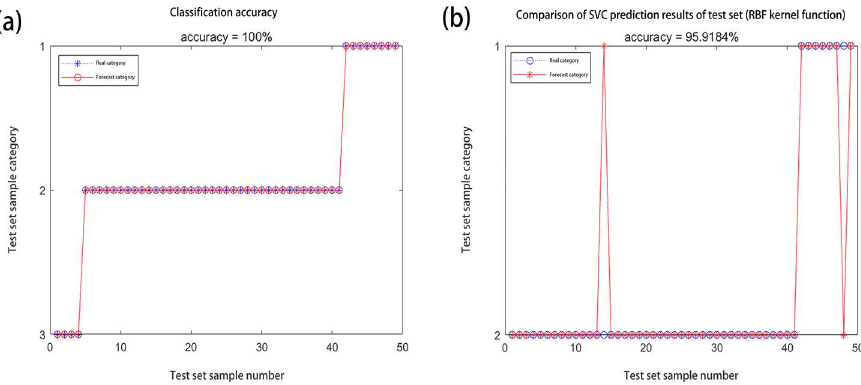
Figure 8. ( a , b ) represent the classification results of BPNN and SVC,